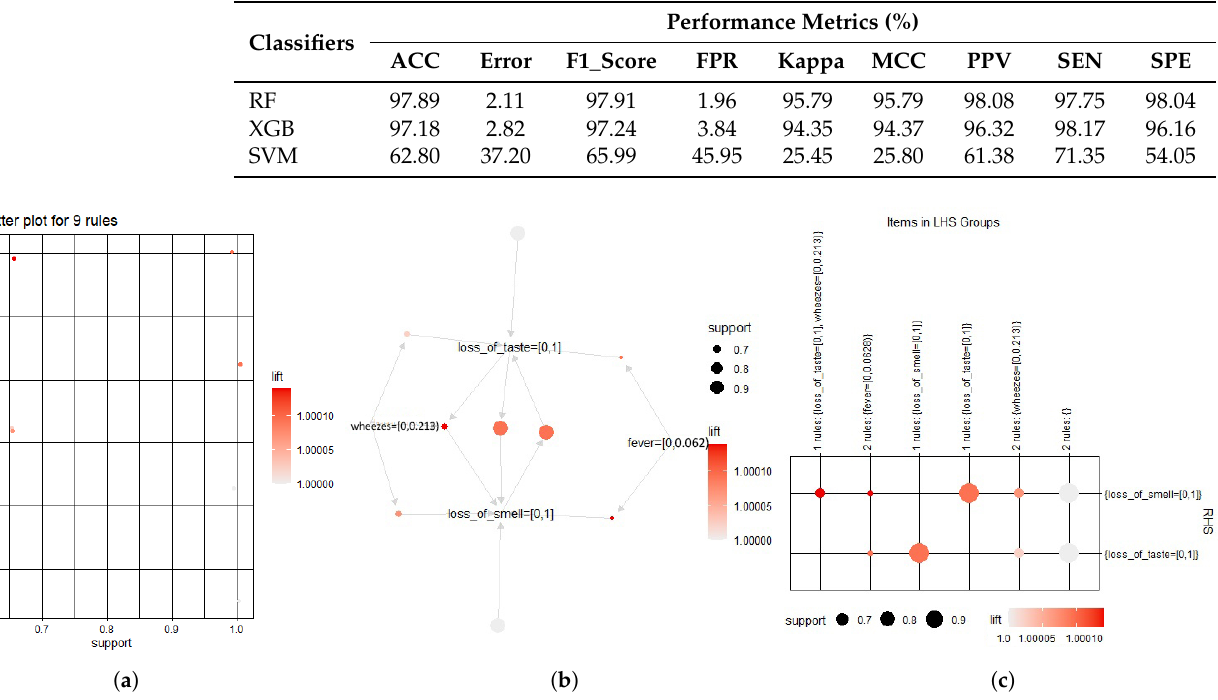
Table 6. Selected feature models performances using RF, XGB, and SVM are quantified in terms of accuracy, error, F1_Score, false-positive rate, and Kappa. The highest degree of precision, accuracy, and specificity is achieved via the efforts of RF.